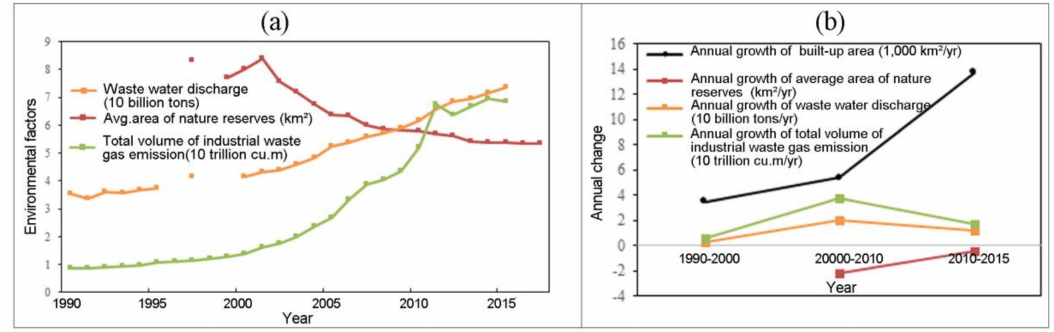
Figure 11. Relationship between built-up area expansion and environmental factors: ( a ) dynamics of built-up area expansion and environmental factors; ( b ) comparison between speed of built-up area expansion and environmental